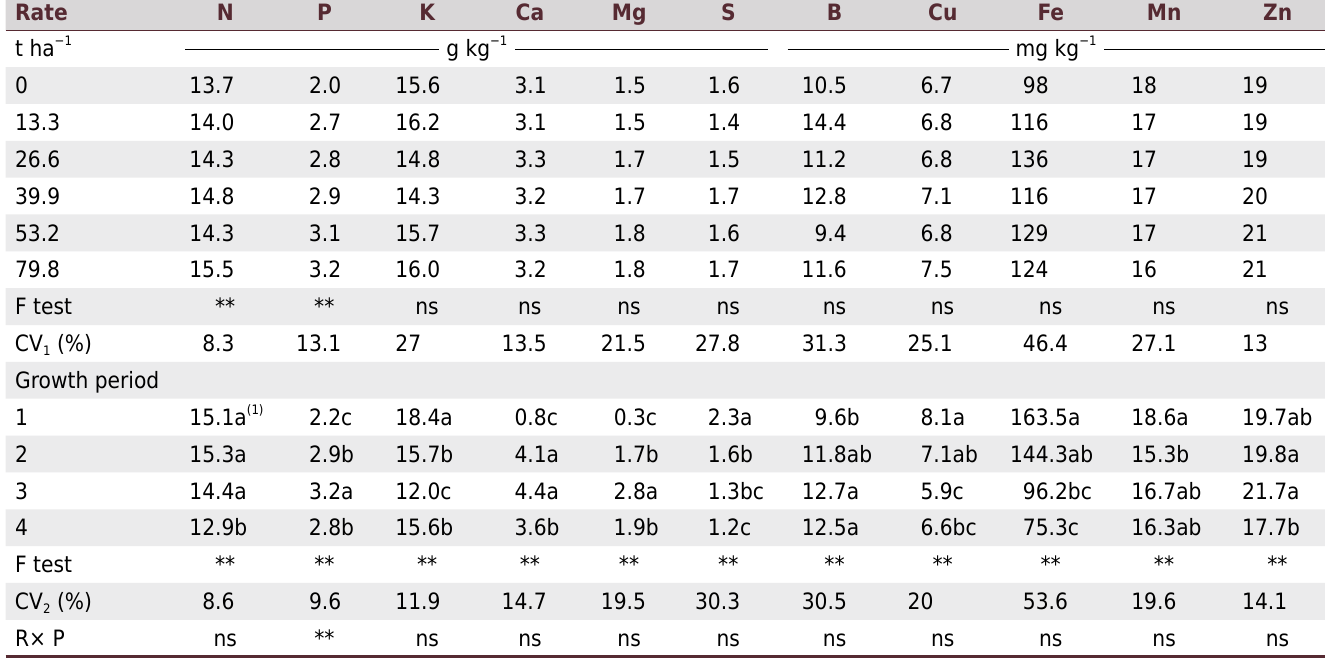
Table 6. Mean values, F test, and coefficient of variation for nutrient contents in the sampled leaf of elephant grass cv. Cameroon in response to organic compost rates Rate